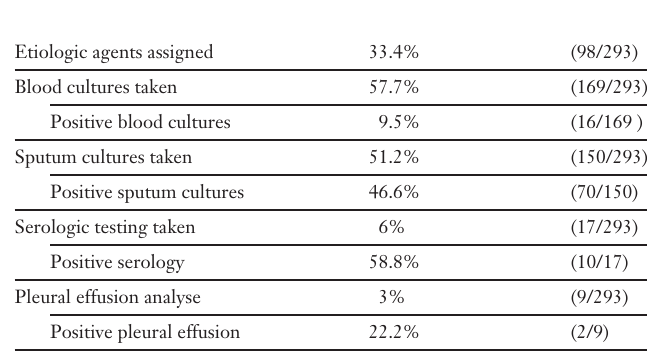
Diagnostic features (n = 293). Legionella serology was consi- dered positive with a single titer of 1:256 or more according to Stout